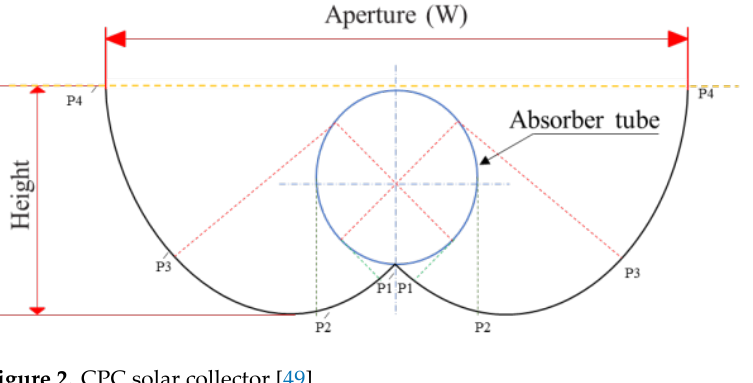
Figure 2. CPC solar collector